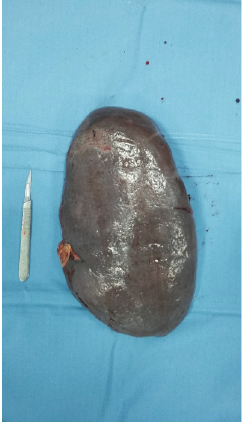
Figure 2: Patient’s spleen after